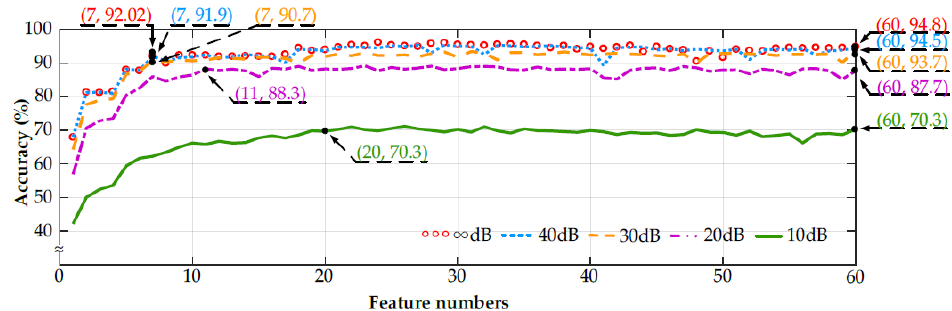
Figure 13. Accuracy curves of the HHT–CFS. The accuracies of the MRA–CFFS (Figure 14) are displayed at 60 feature numbers and the accuracies of the HHT–CFFS (Figure 15) are displayed at 70 feature numbers under different noise conditions. The comparison results are summarized below. The accuracies under different noise conditions of the MRA–CFFS are higher than the accuracy of the HHT–CFFS. (1) In ∞ dB, MRA: 92%, HHT: 83.5%; (2) In 40 dB, MRA: 91.8%, HHT: 82.7%; (3) In 30 dB, MRA: 91.3%, HHT: 81.5%; (4) In 20 dB, MRA: 91%, HHT: 73.3%; (5) In 10 dB, MRA: 89.8%, HHT: 66%. Figure 14. Accuracy curves of the MRA–CFFS.